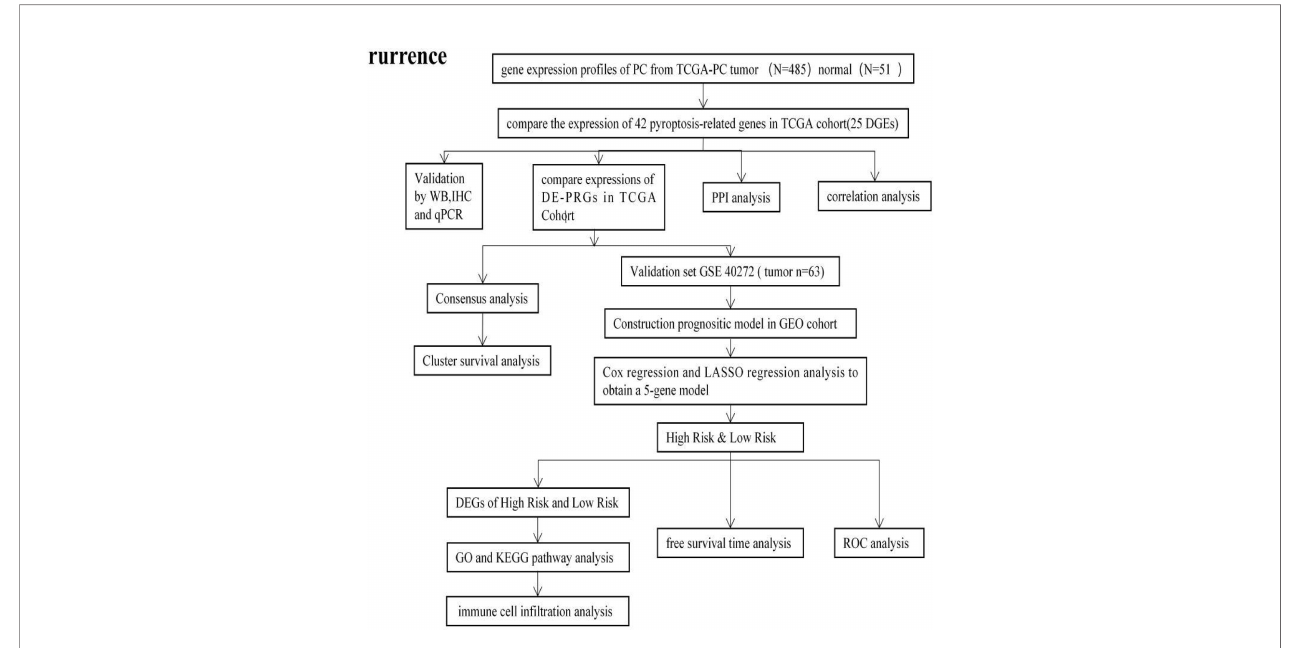
FIGURE 1 | The fl owchart of the overall procedures. This fl owchart illustrates the process of data collection and analysis for prognostic